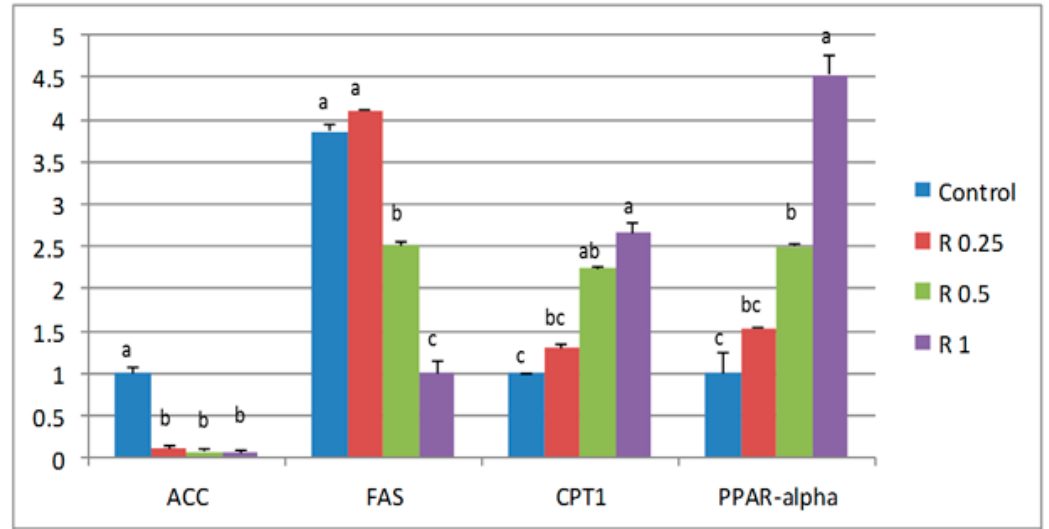
Figure 2. Effect of dietary rutin on the relative expression of ACC , FAS , CPT1 , and PPAR- α in broiler livers. Each bar carrying different letters (a,b,c) was significantly different ( p < 0.05) (mean ± standard error, n = 10).